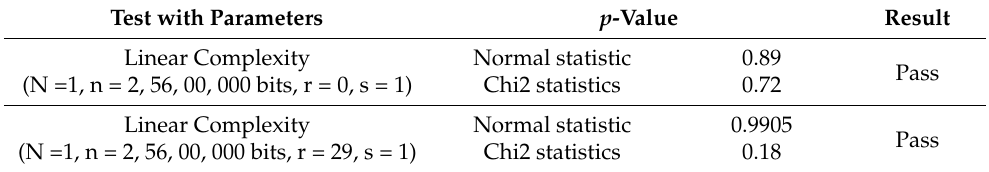
Table 4. Entropy rate of the raw true random bits.